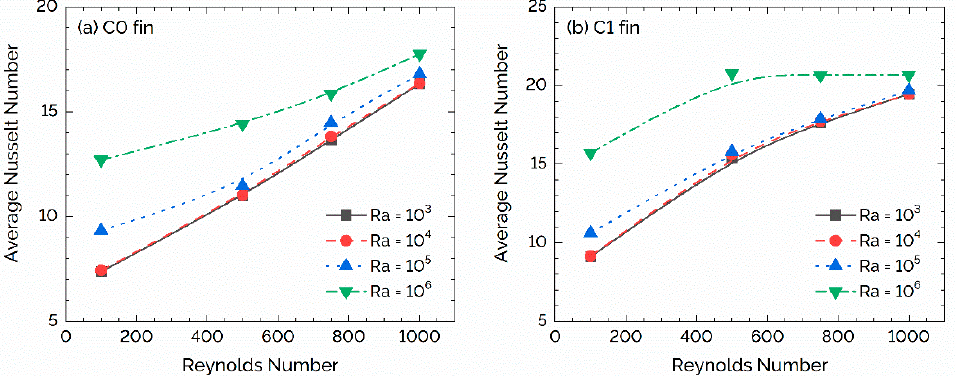
Figure 6. Effect of varying Rayleigh and Reynolds numbers on the rectangular fin (C0 fin) and alveolar fin (C1 fin).